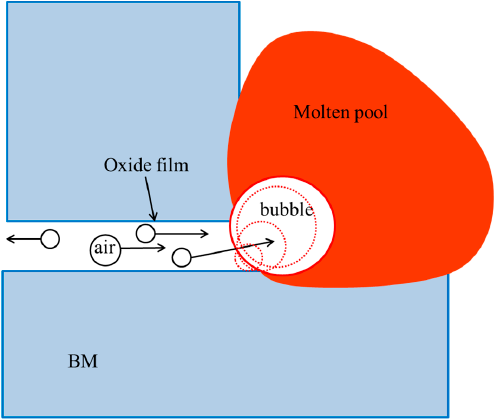
Figure 11. Pore-forming mechanism at incomplete penetration.